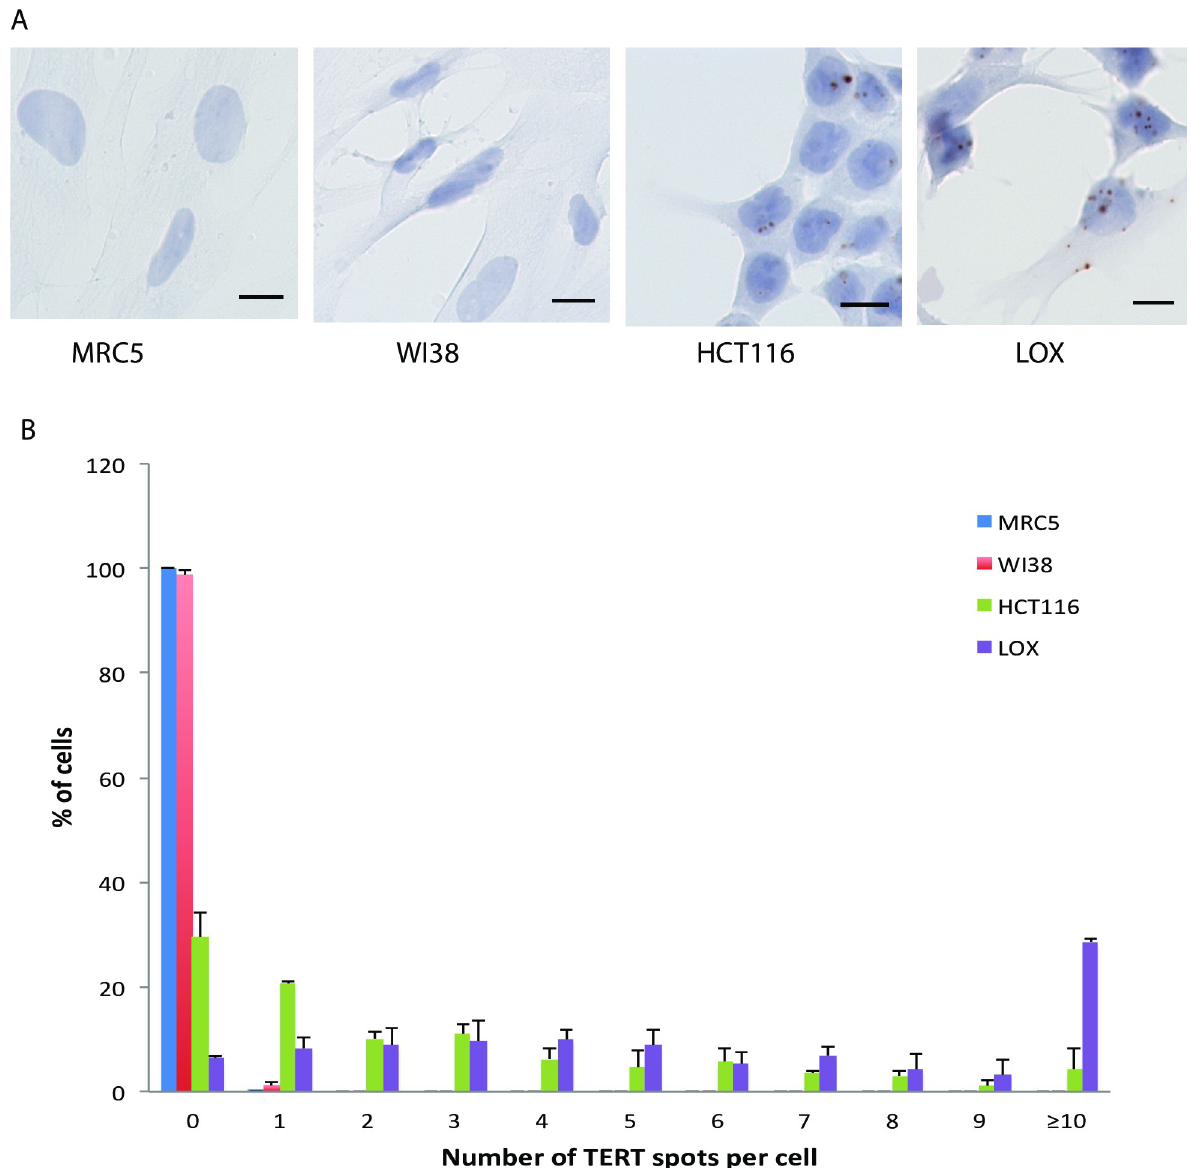
Fig 2. RNAscope controls. A. RNAscope for TERT expression in telomerase negative (MRC5 and WI38 fibroblast) and positive (HCT116 and LOX) cell lines. B. Frequency distribution of TERT RNAscope signals within populations of MRC5, WI38, HCT 116 and LOX cells. The data is from 3 sets of biological replicates each containing 100 cells for all cell types. Scale bars denote 10 μ